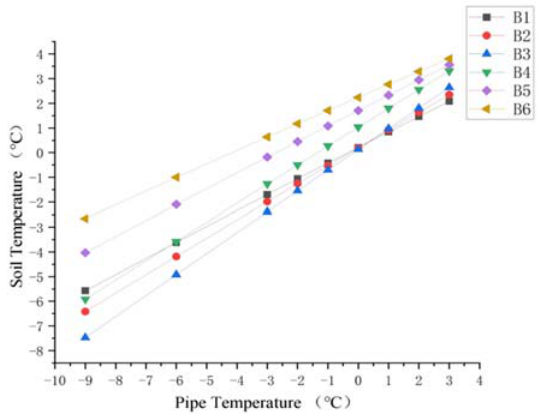
Figure 14. Diagram of soil temperature trend at point B1–B6.